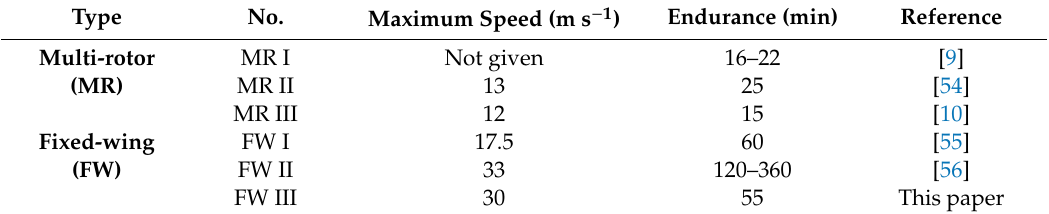
Table 6. Flight e ffi ciency comparison for two types of